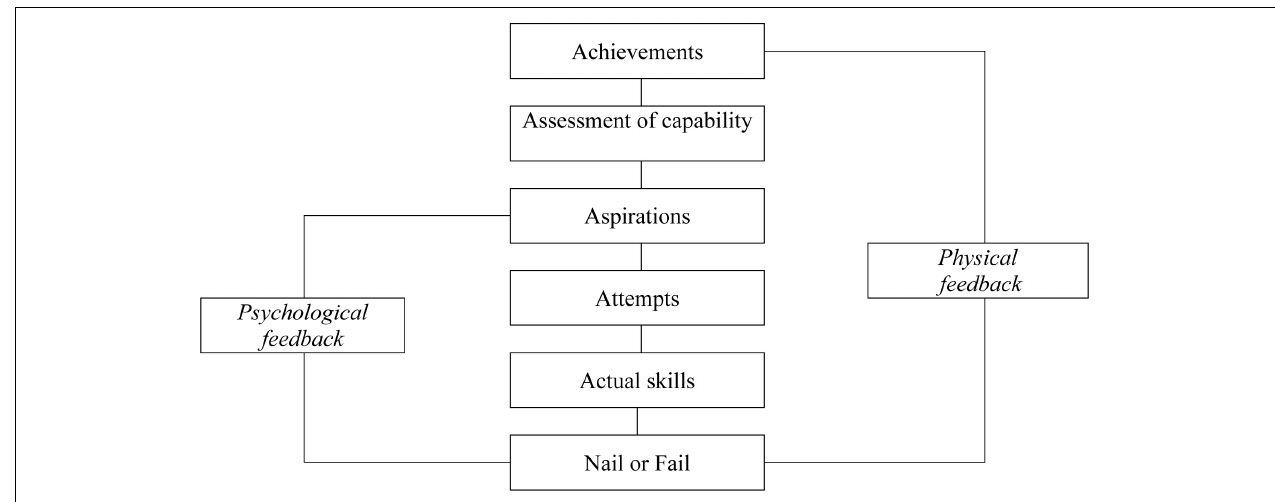
FIGURE 3 | Achievements, aspirations, and